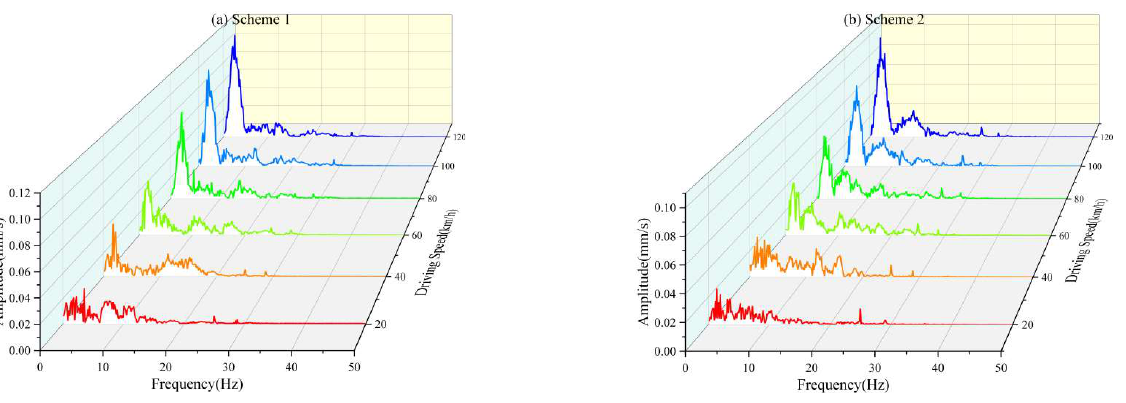
Figure 8. Frequency–domain curve of vibration velocity with driving speed.